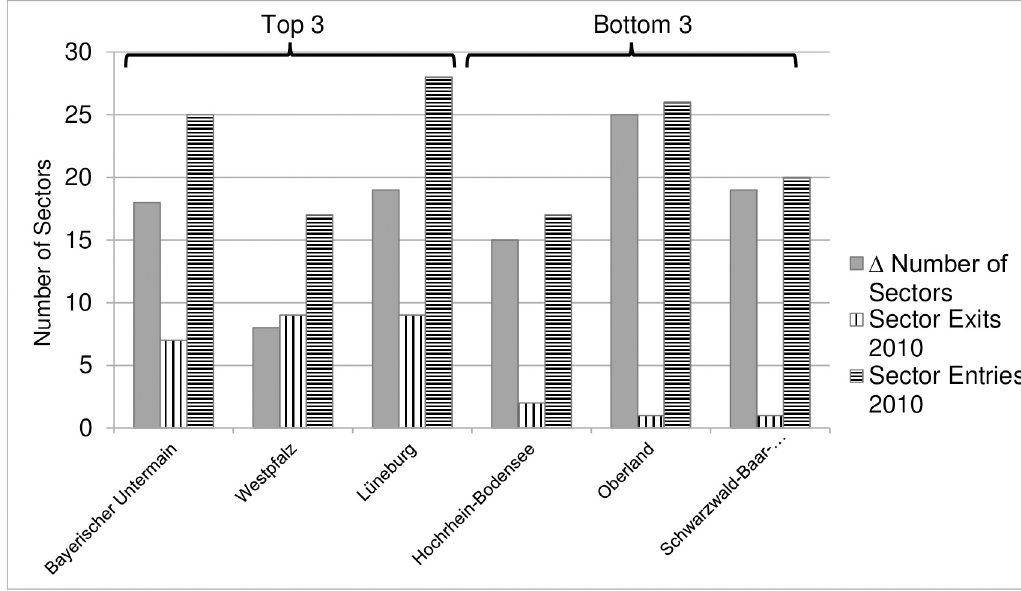
Fig 10. Entries and exits of industries in highest and lowest performing regions in terms of increase in RV. (Year of observation 2010, year of reference 1976). Source: Authors.